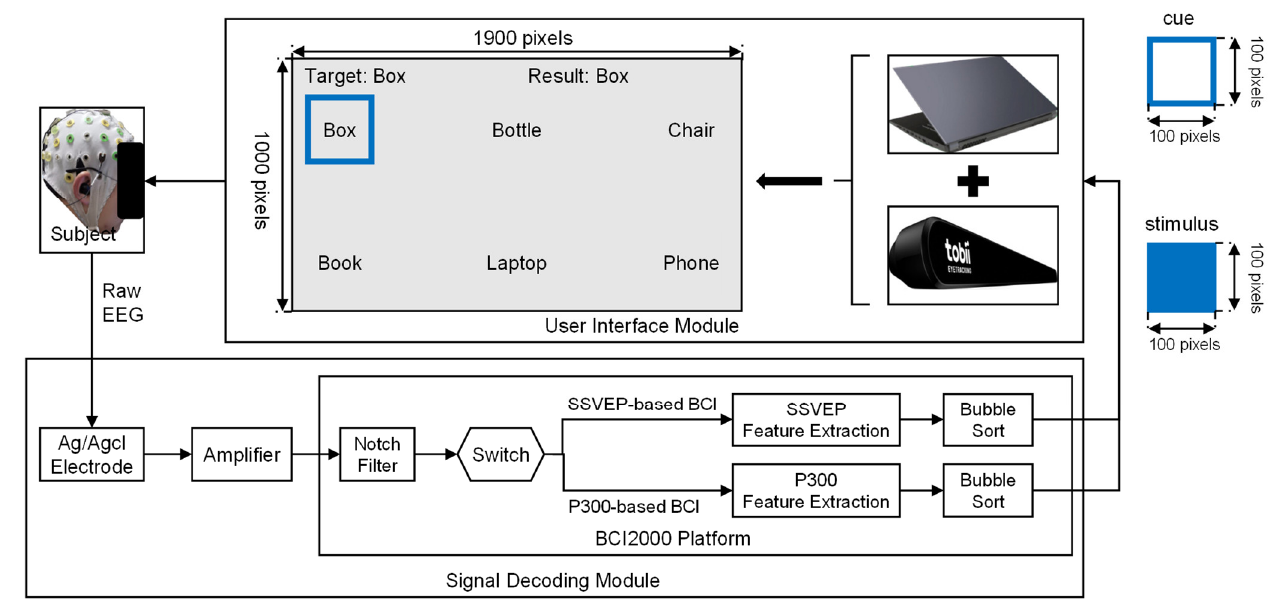
Figure 1. The architecture of the P300-based BCI and the SSVEP-based BCI used in this study. The two BCIs ran on the same laptop and could be converted between each other with a switch. The user interface of the two BCIs was a laptop screen with a size of 1900 pixels 1000 pixels; the size of each stimulus in the user interface was 100 pixels. We used a blue visual cue to mark the current target and a blue stimulus to evoke users’ EEG signals. The text after “Target” and “Result” presented the current target and decoding result,